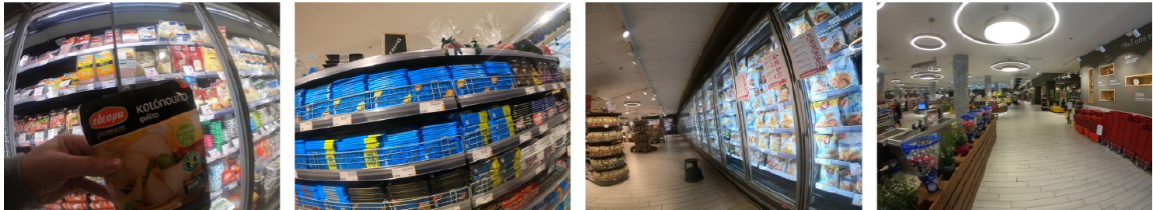
FIG. 7 Egocentric images depicting the classes in the supermarket activity namely (left to right): a) product, b) shelf, c) trail and d) other, from an actual visit to a super- market by a visually impaired